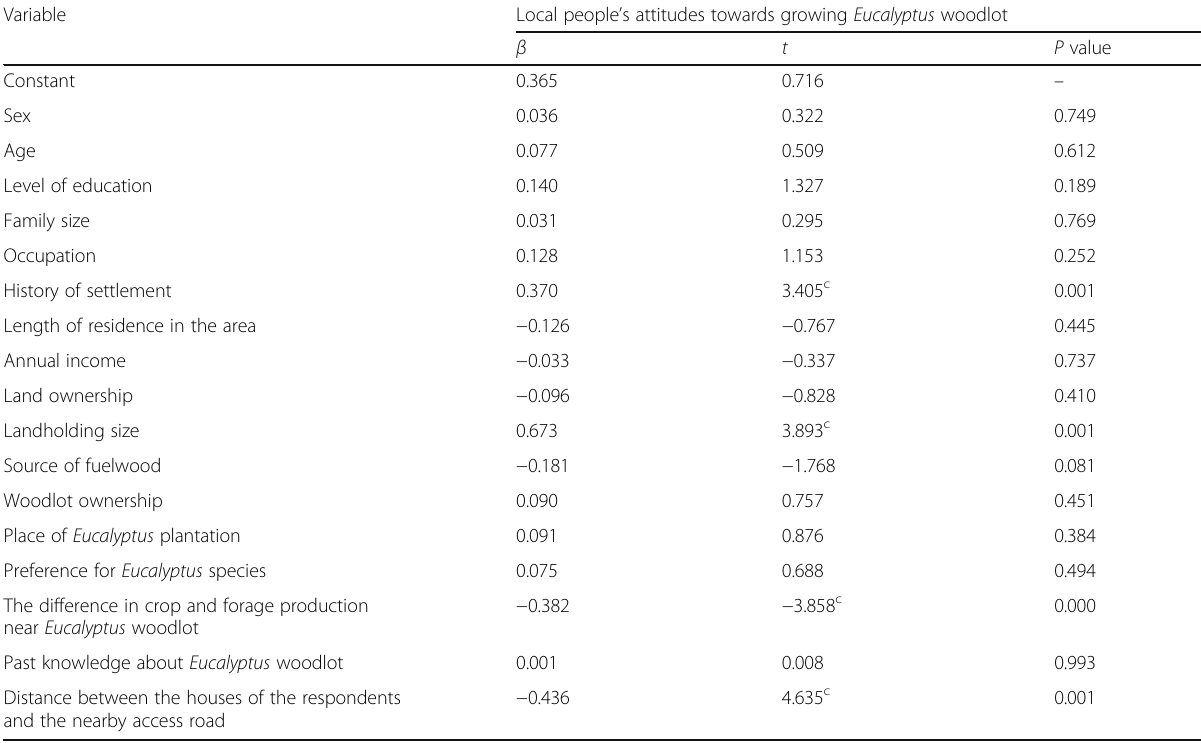
Table 6 Linear regression model a to predict local people ’ s attitudes towards growing Eucalyptus woodlot in Gudo Beret Kebele b